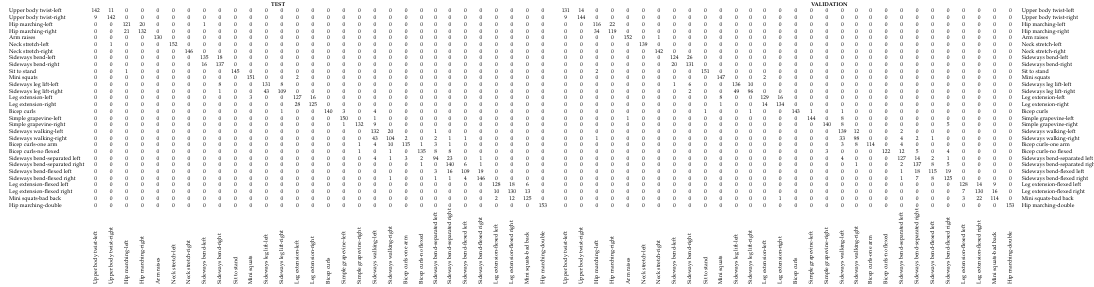
Table 1. Confusion matrix for test and validation data with 250